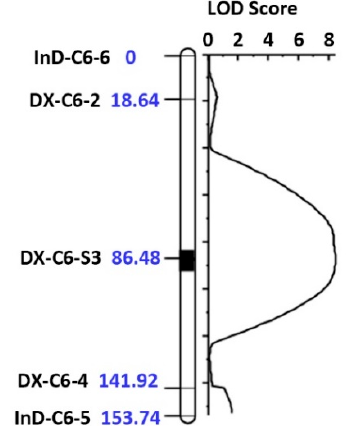
Figure 5. Confirmation of qML6 via an F 2 segregating population. The position of the significant QTL, qML6-1 , is illustrated by the solid black bar within the chromosome, and the LOD scores are shown on the right. On the left, the black text represents the molecular marker, and the blue text indicates the linkage position of the corresponding molecular marker on chromosome 6. The marker space unit is